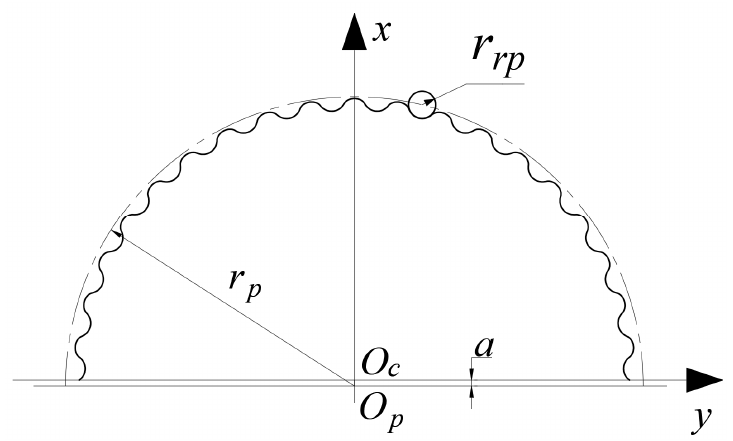
Figure 4. Schematic diagram of a standard cycloidal tooth profile.